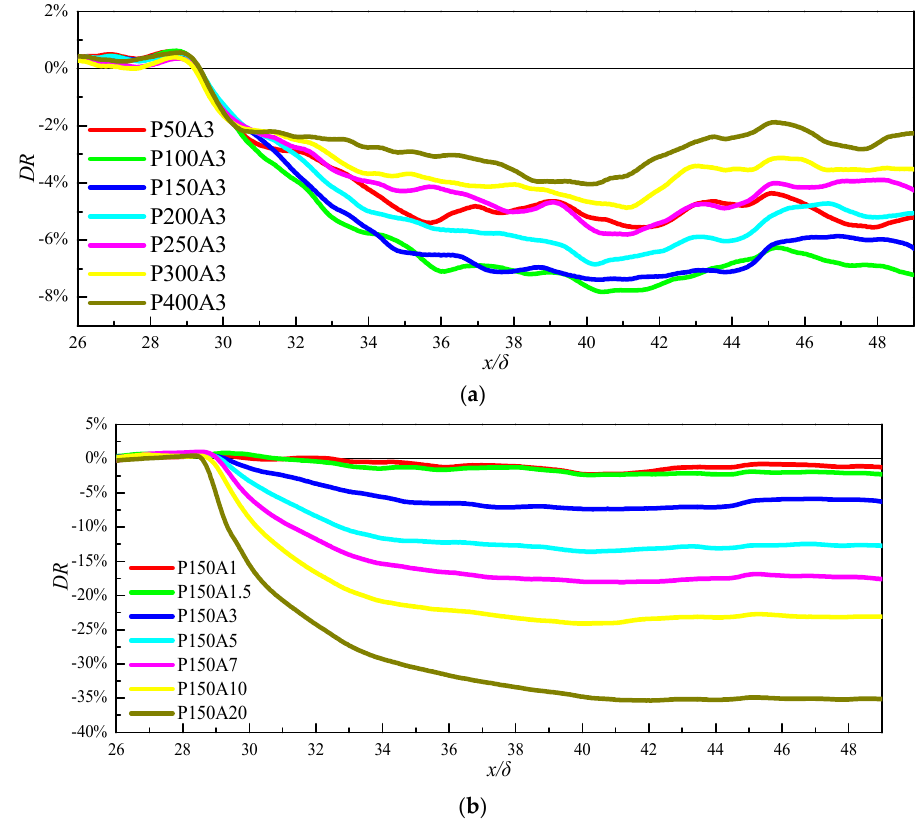
Figure 5. The rates of the change of drag ( DR ) for Group 1 ( a ) and Group 2 ( b ).